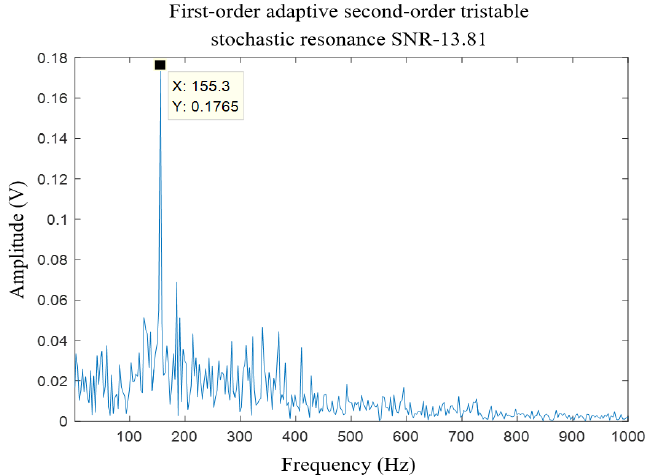
Figure 15. The envelope spectrum of high-pass filtered signal.